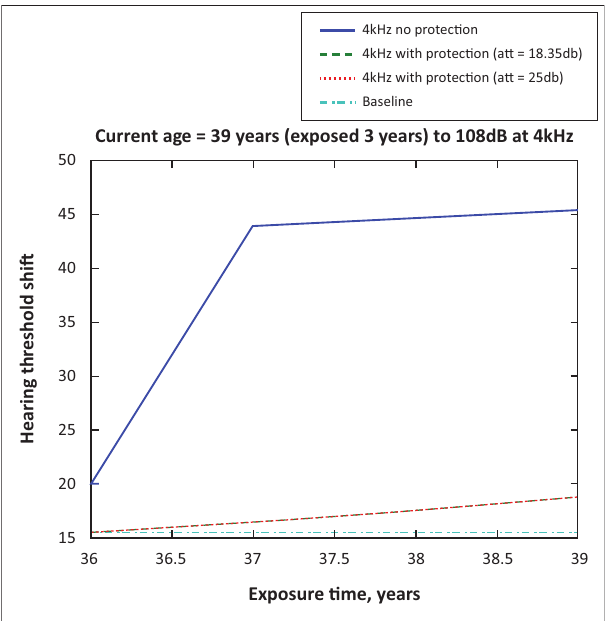
Source : Figure created using data from Moroe, N.F. (2018). Occupational noise-induced hearing loss in South African large scale mines: From policy formulation to implementation and monitoring . Doctoral thesis. Johannesburg: University of the Witwatersrand. FIGURE 4: Thirty-nine years old at 4000 Hz with exposure levels of 108